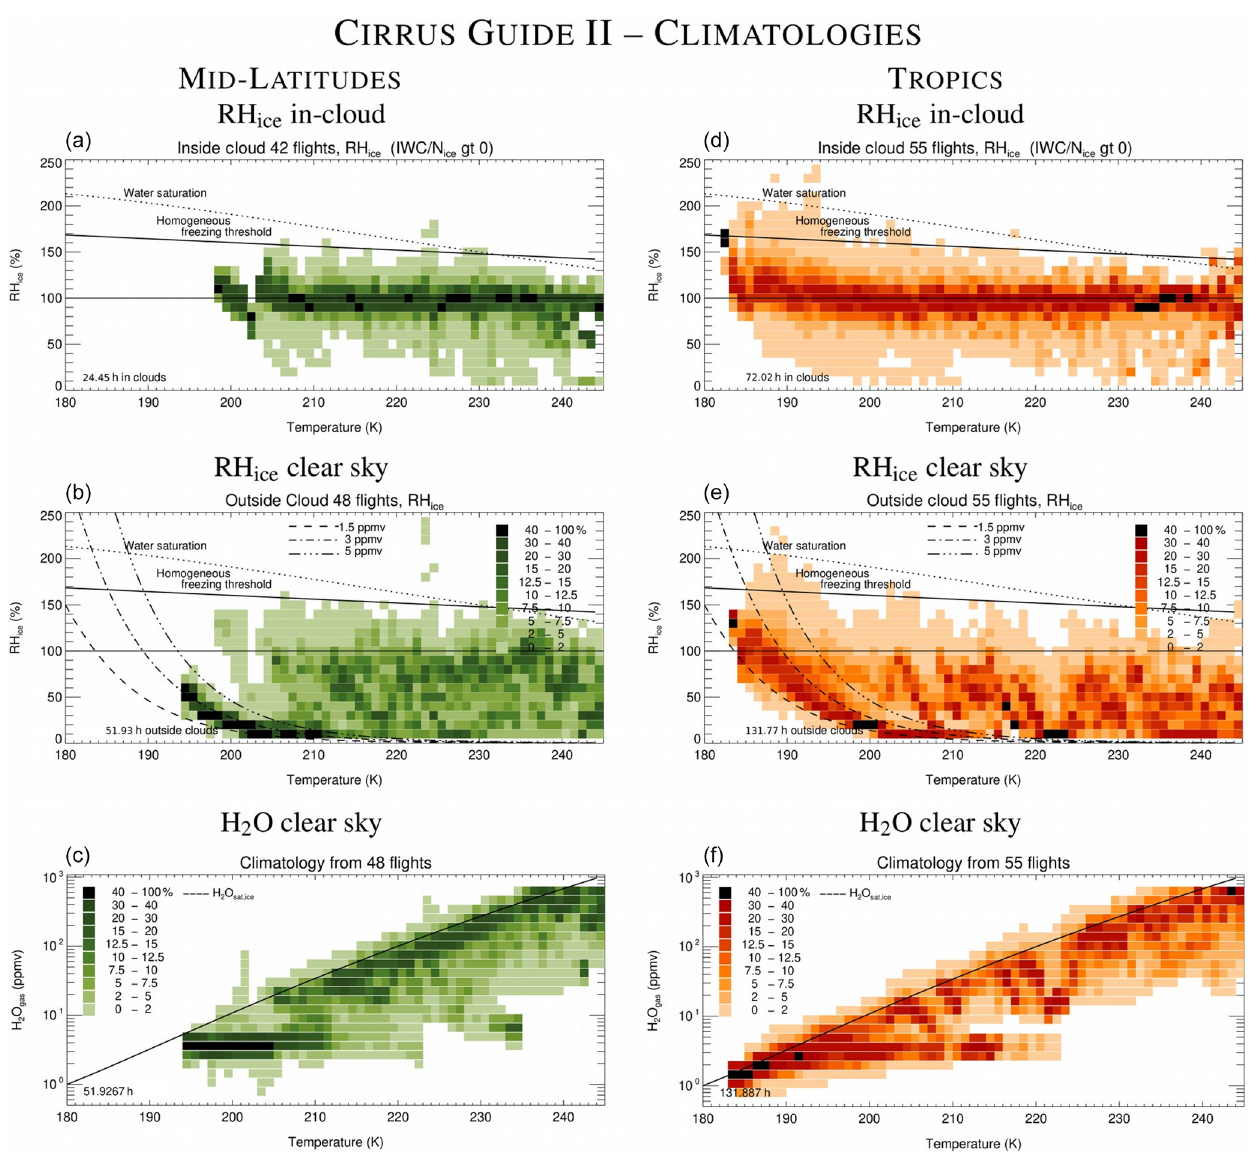
Figure 9. Same as Fig. 7d–f, but for midlatitudes and tropics. The field campaigns are listed in Table A2.